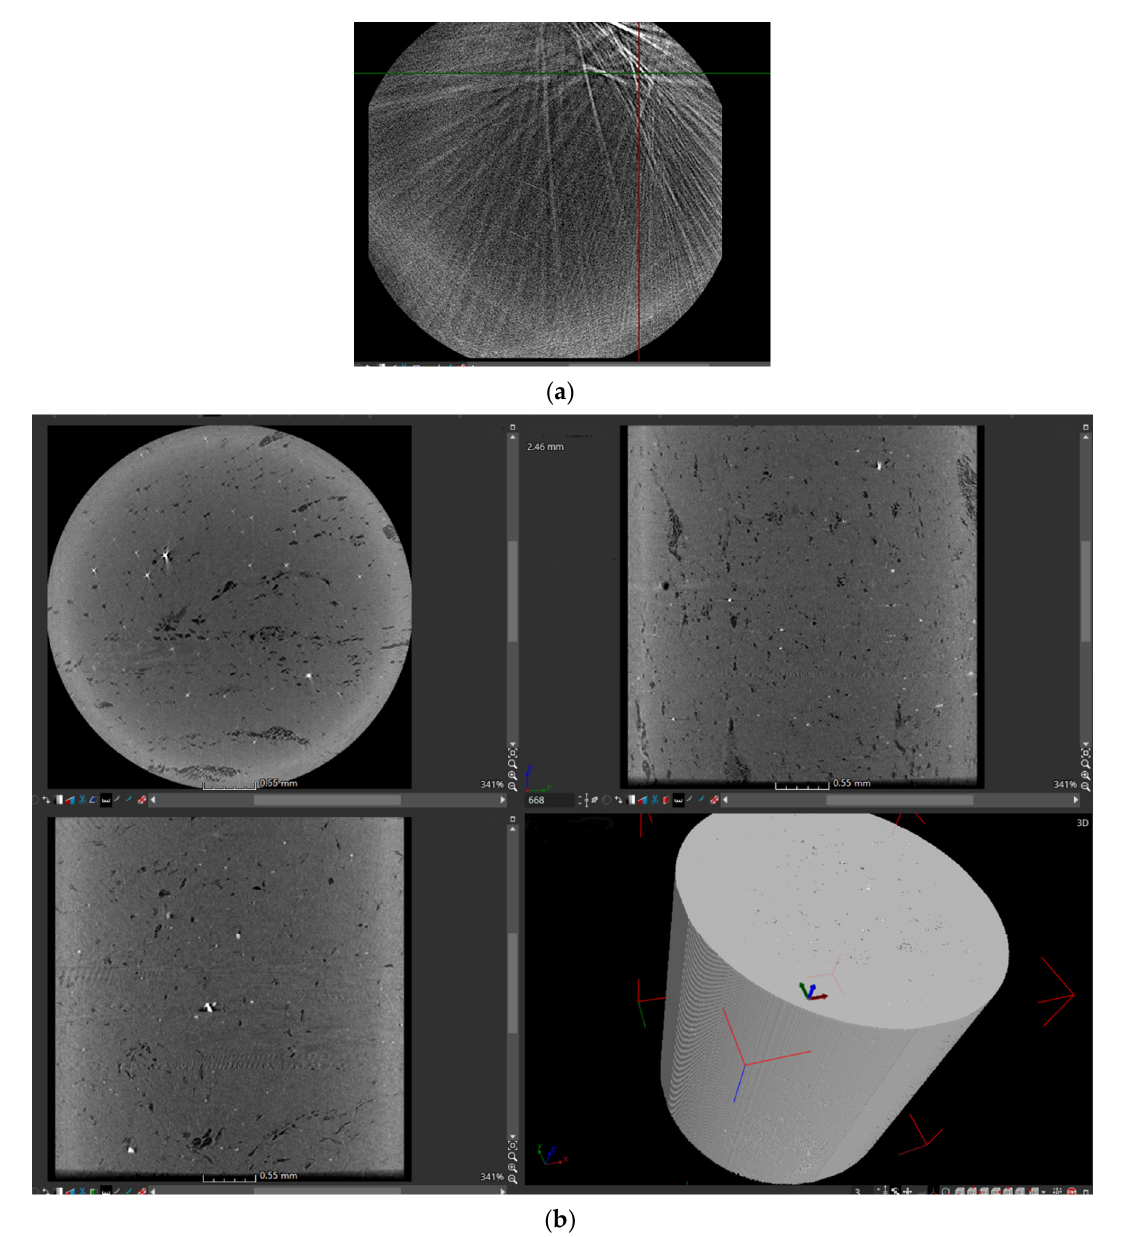
Figure 4. Image of three-dimensional reconstruction with ray artifacts. ( a ) Radial lines, and ( b ) three-dimensional image.